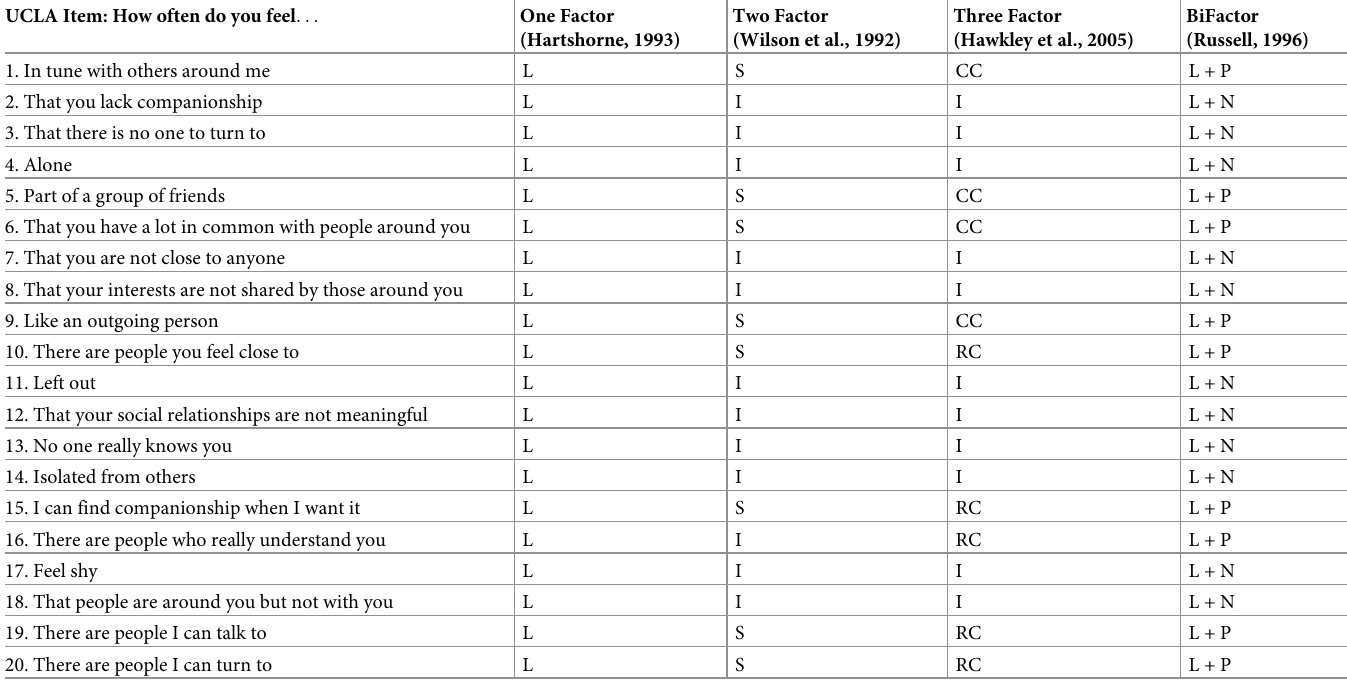
Table 1. Item loading specification in proposed factor models of the UCLA Loneliness